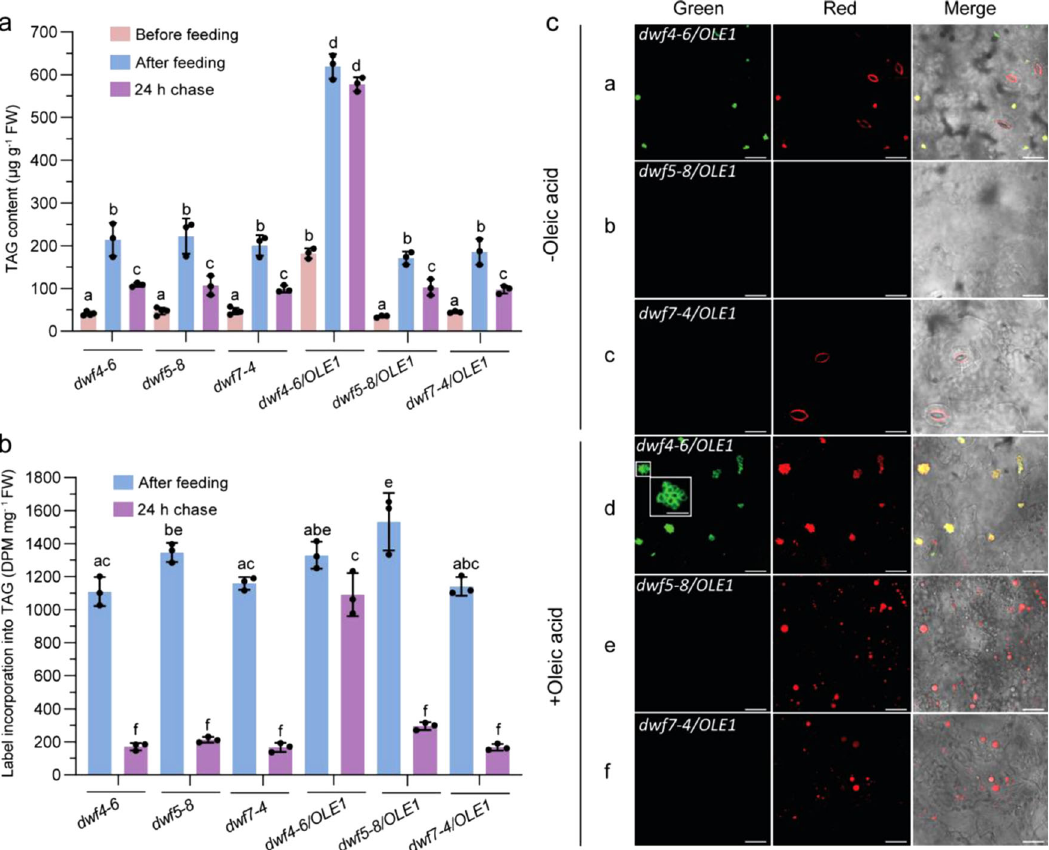
Fig. 4 TAG metabolism and LD accumulation in leaves of dwf mutants as revealed by oleic acid feeding. a TAG contents in leaves before oleic acid feeding, after 0.5 mM cold oleic acid feeding for overnight and after 24 h of chase. Lipids were extracted from leaves and quanti fi ed by GC-MS. Four biological replicates were performed for dwf4-6 , dwf5-8, and dwf7-4 before feeding while the others had three biological replicates. b Label incorporation into TAG in leaves after 14 C-oleic acid feeding and after 24 h of chase. Lipids were extracted from leaves and separated by TLC. Radiolabeled TAGs were quanti fi ed by liquid scintillation counting. Three biological replicates were carried out for each sample. c LDs in leaves after 0.5 mM cold oleic acid feeding for overnight. LDs were stained by BODIPY red and observed with a confocal scanning laser microscope. The experiment was repeated 3 times with similar results. Bars = 20 μ m (5 μ m in insert). In a and b , data are mean ± SD. Different letters indicate signi fi cant differences at P < 0.05, as determined by one- way ANOVA with Tukey ’ s multiple comparisons